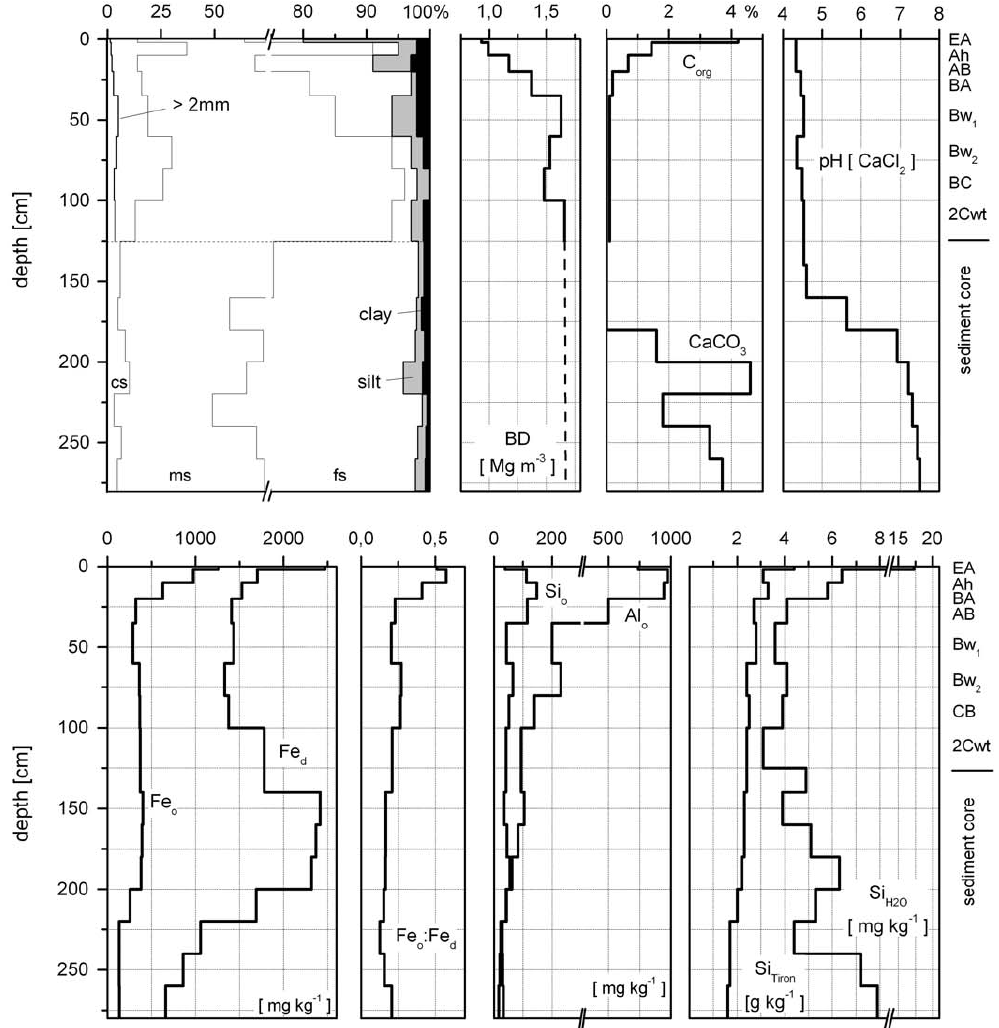
Fig. 1. Depth functions of basic soil properties from the Brunic Arenosol (Dystric)